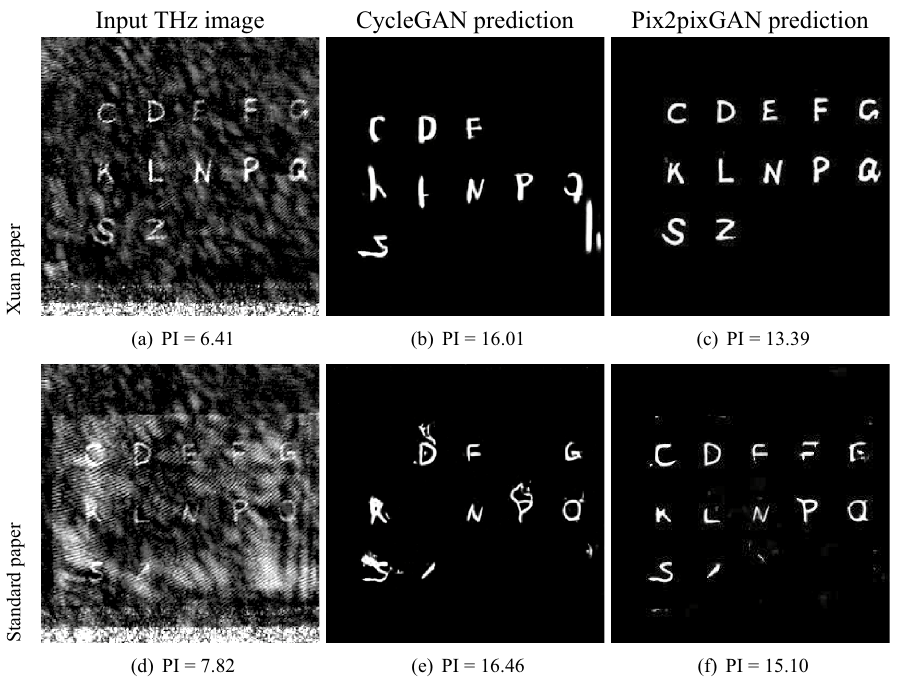
Figure 6. The CycleGAN and Pix2pixGAN results of two exemplary real THz images written on Xuan paper (top row) and standard paper (bottom row), respectively.